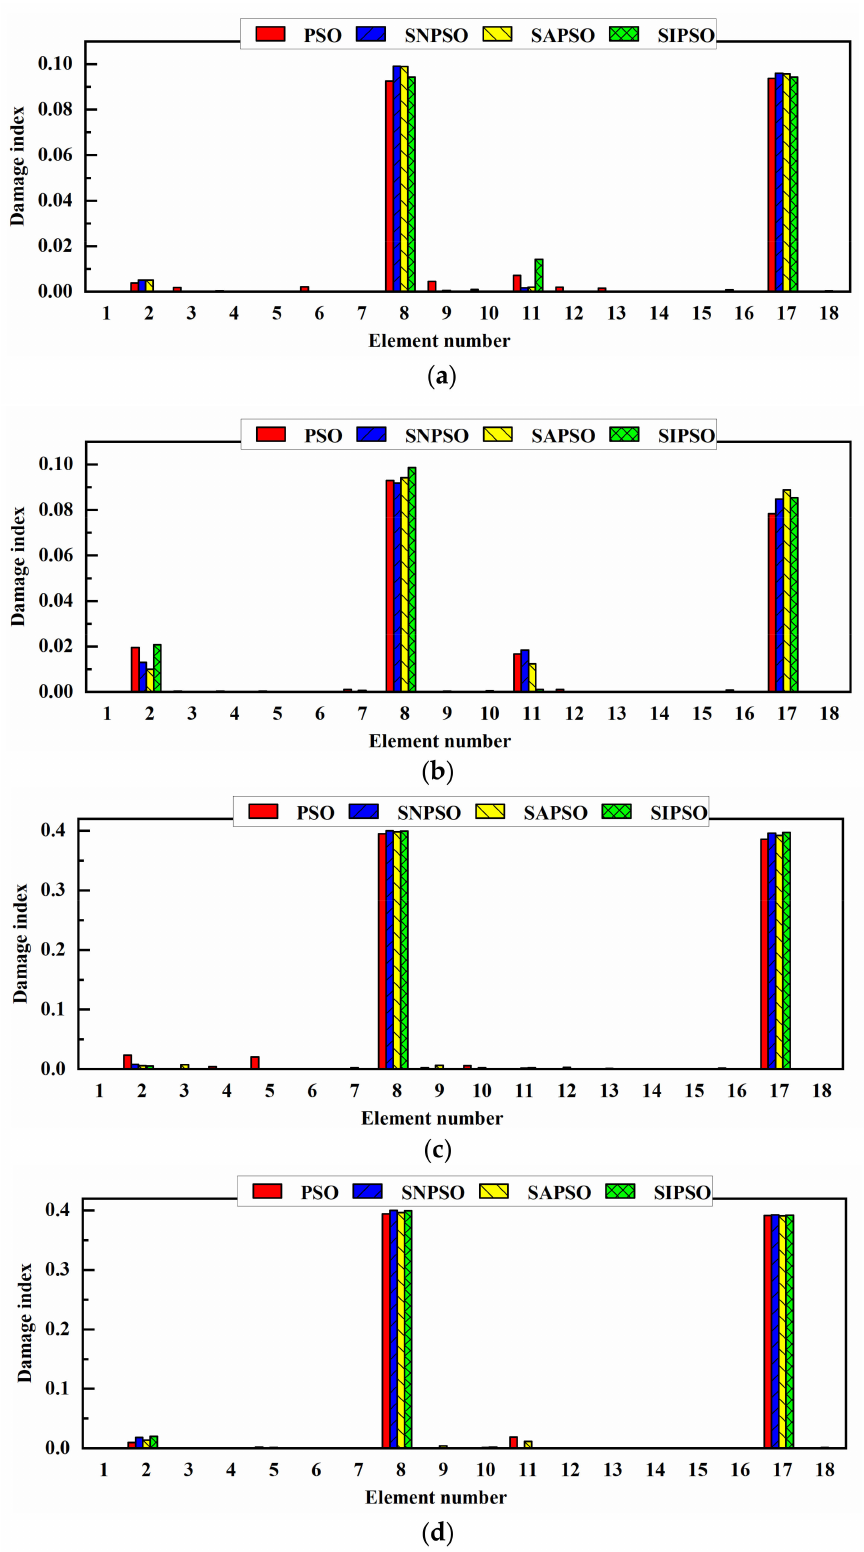
Figure 8. Double damages detection results of four PSO-based algorithms: ( a ) 10% damage index with 5% noise level; ( b ) 10% damage index with 10% noise level; ( c ) 40% damage index with 5% noise level; ( d ) 40% damage index with 10% noise